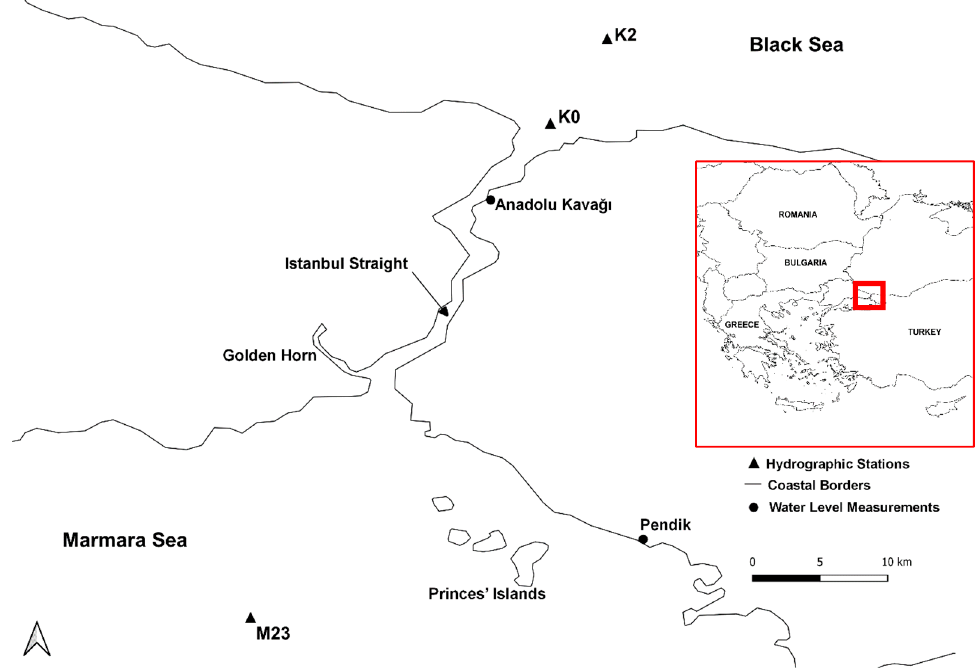
Figure 1. Study area and hydrographic observation stations in the Istanbul strait [25].